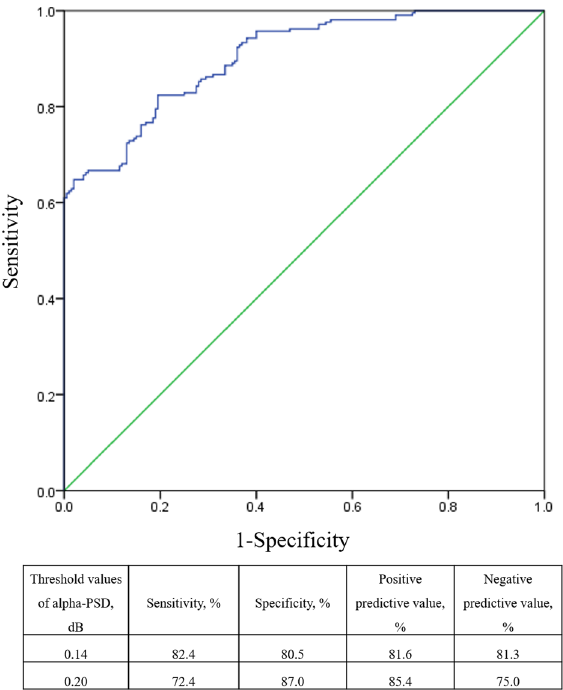
Figure 3. ROC curve (blue line) and predictive values according to the cutoff of alpha-PSDs; under the curve (AUC) of 0.903 and p value <